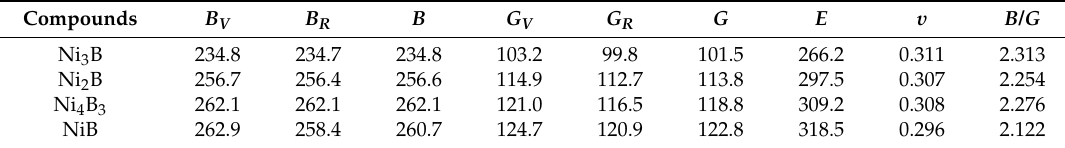
Table 3. Bulk modulus ( B ), Shear modulus ( G ), Young’s modulus ( E ), and Poisson’s ratio ( υ ) of the Ni x B y